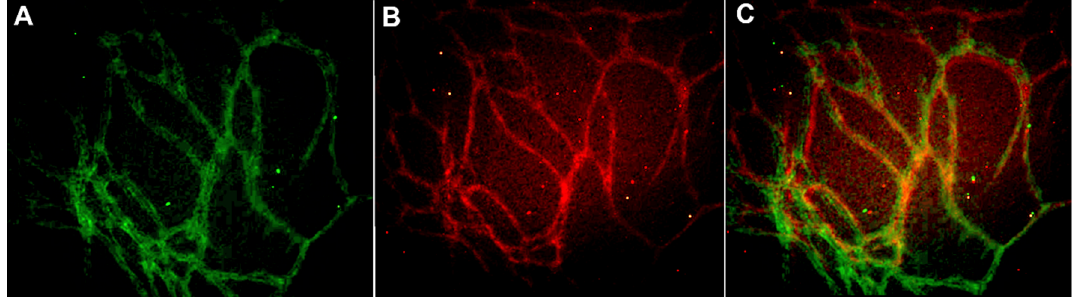
Figure 1. Vascular structures cultured on 384-well plate and stained with ( A ) anti-collagen IV (FITC-green) and ( B ) anti-von Willebrand factor (VWF) (TRITC-red) antibodies. The merged image is seen in ( C ). The edges and square shape of the 384 well plate caused some challenges in obtaining representative images from the formed vascular network. Image obtained with Cell-IQ with 10x objective.